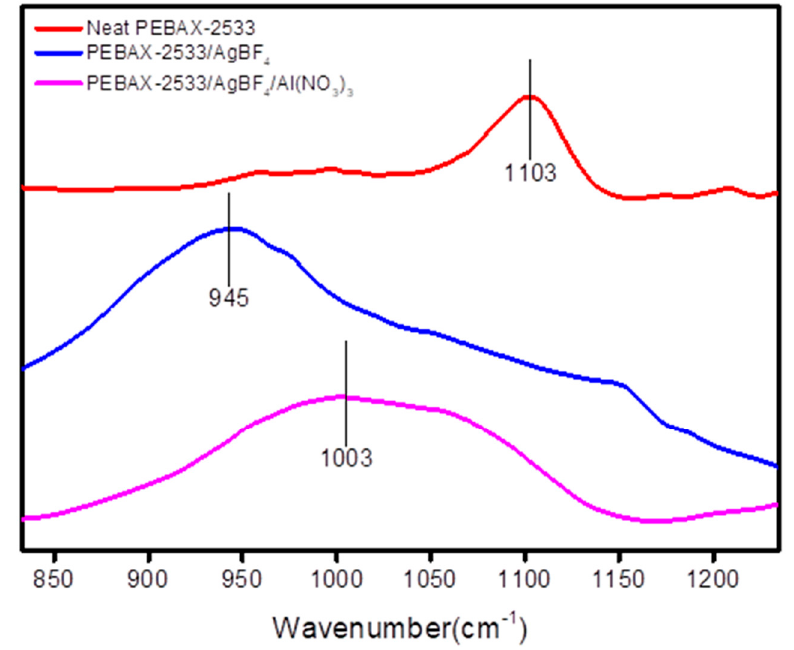
Figure 2. FT-IR spectra of the ether group of neat PEBAX-2533, PEBAX-2533/metal salt and PEBAX- 2533/metal salt/Al salt.